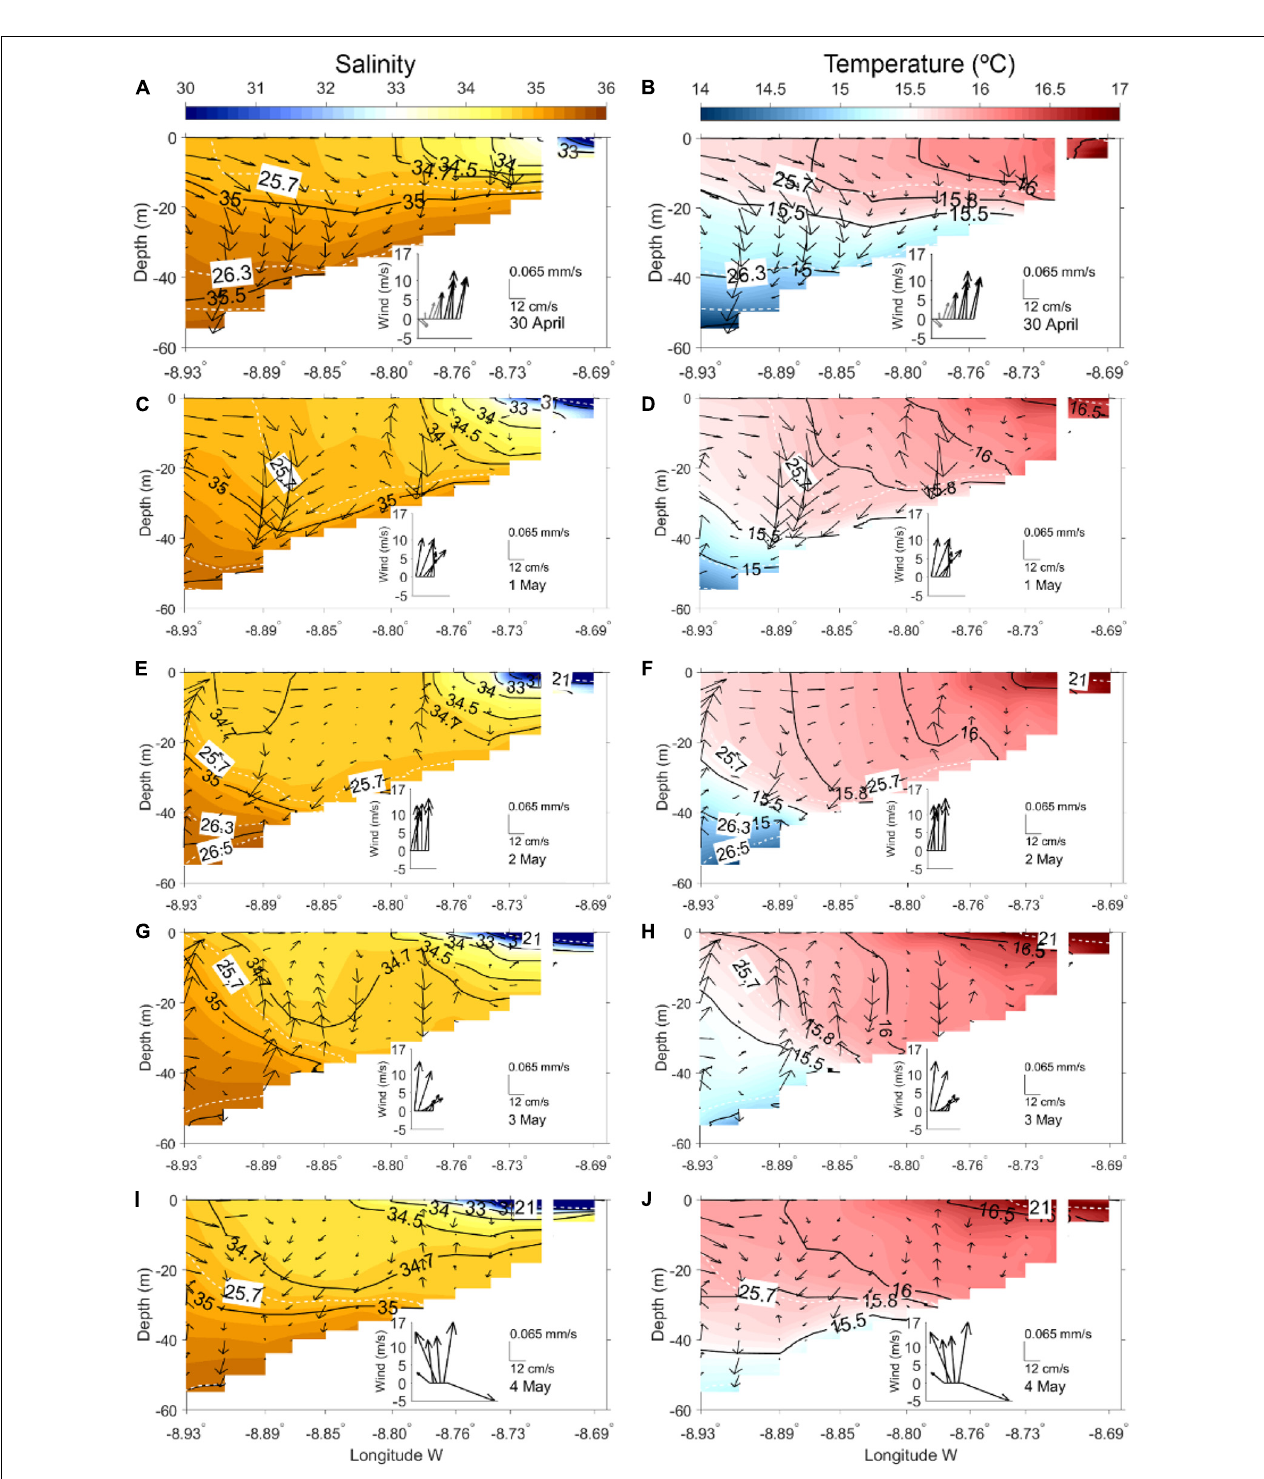
FIGURE 8 | Same as Figure 6 for days 30 April, 1, 2, 3, and 4 May.